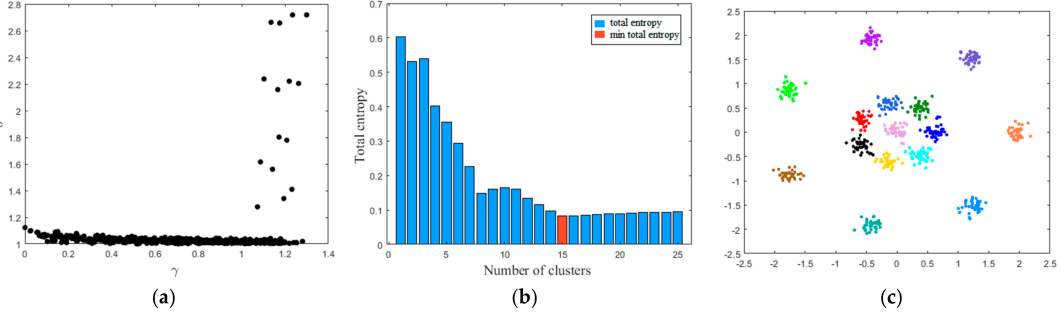
Figure 3. MDPC on the R15 dataset: ( a ) γ − δ decision graph; ( b ) total entropy with different number of clusters; ( c ) visual clustering result.